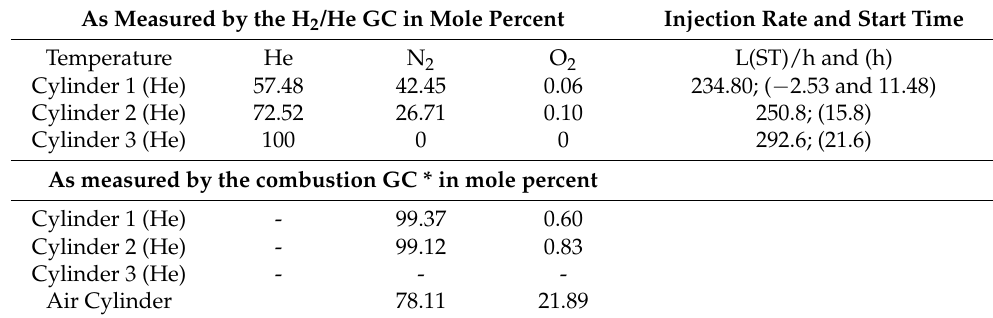
Table 5. Gas cylinders and operation details.